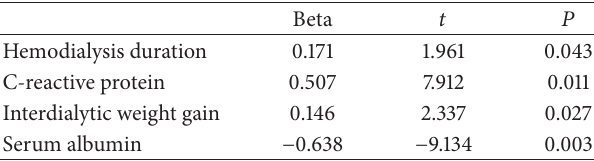
Table 4: Backward linear regression analyses of factors related to elevated